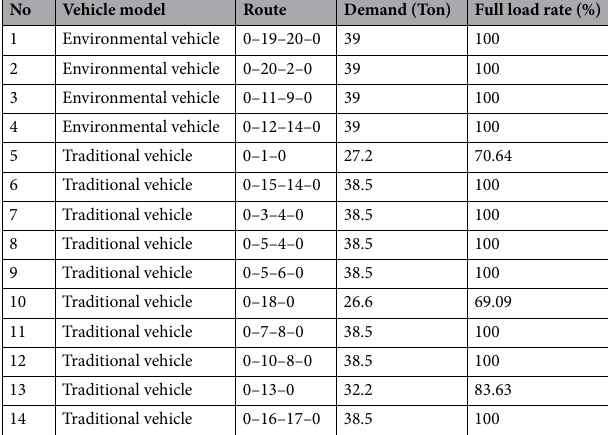
Table 1. MTV routing optimisation results.